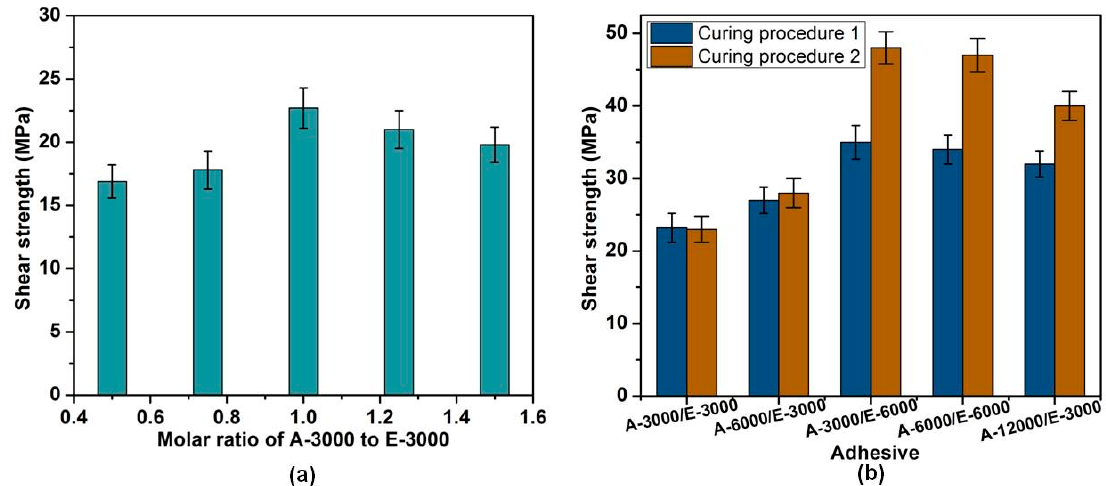
Figure 5. The shear strength of adhesives cured with ( a ) various molar ratios of A-3000 to E-3000, and ( b ) various procedures, the molar ratio of the two selected polymers was 1:1.